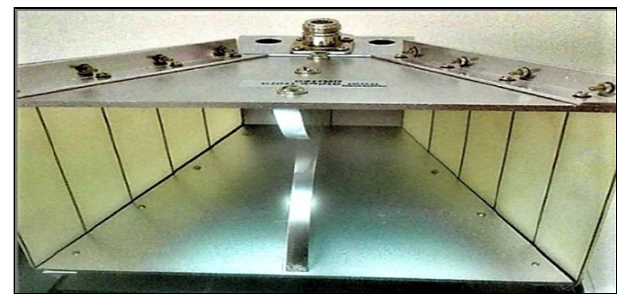
FIGURE 2. Amitec DRH20 dual-ridge horn antenna